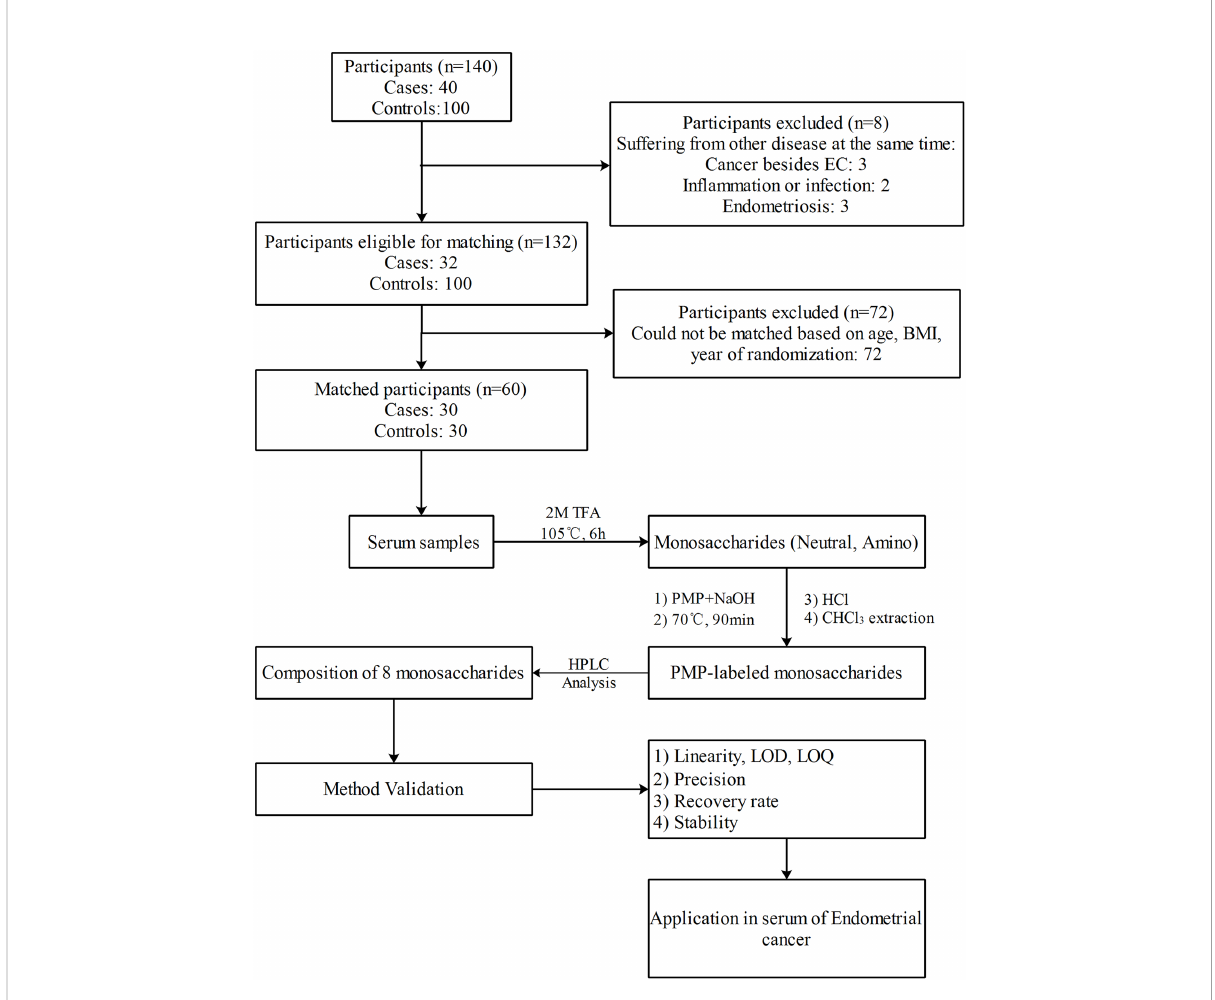
FIGURE 1 The scheme of the experiment